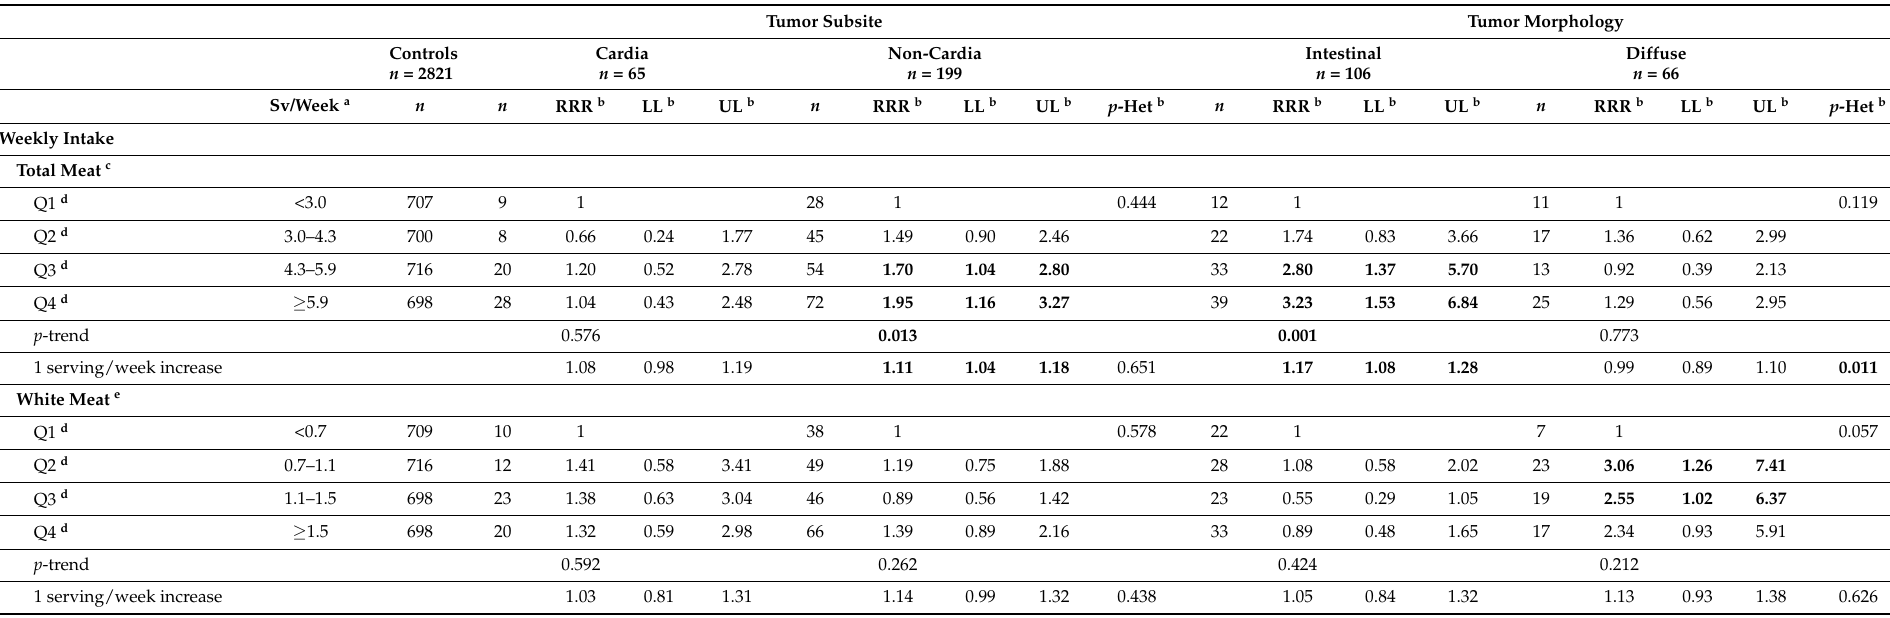
Table 4. Association between gastric adenocarcinoma incidence and total, white, red, and processed meat consumption by tumor subsite (cardia, non-cardia) and morphology (intestinal, diffuse). Tumor Subsite Tumor